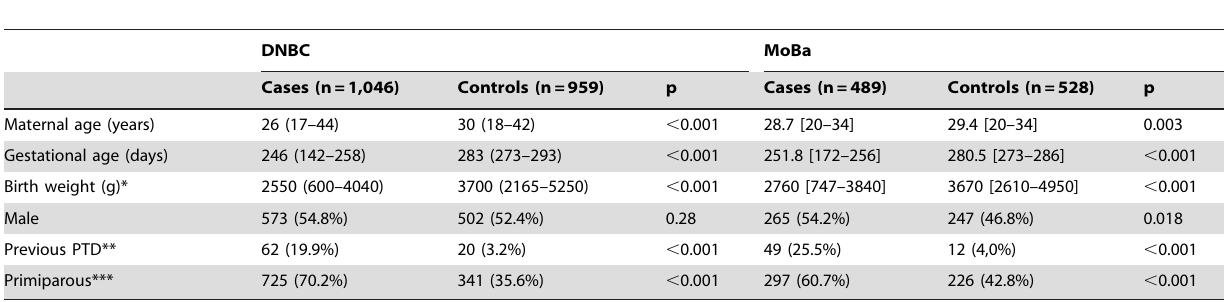
Table 1. Demographic and pregnancy characteristics for the cases and controls in the Danish and Norwegian